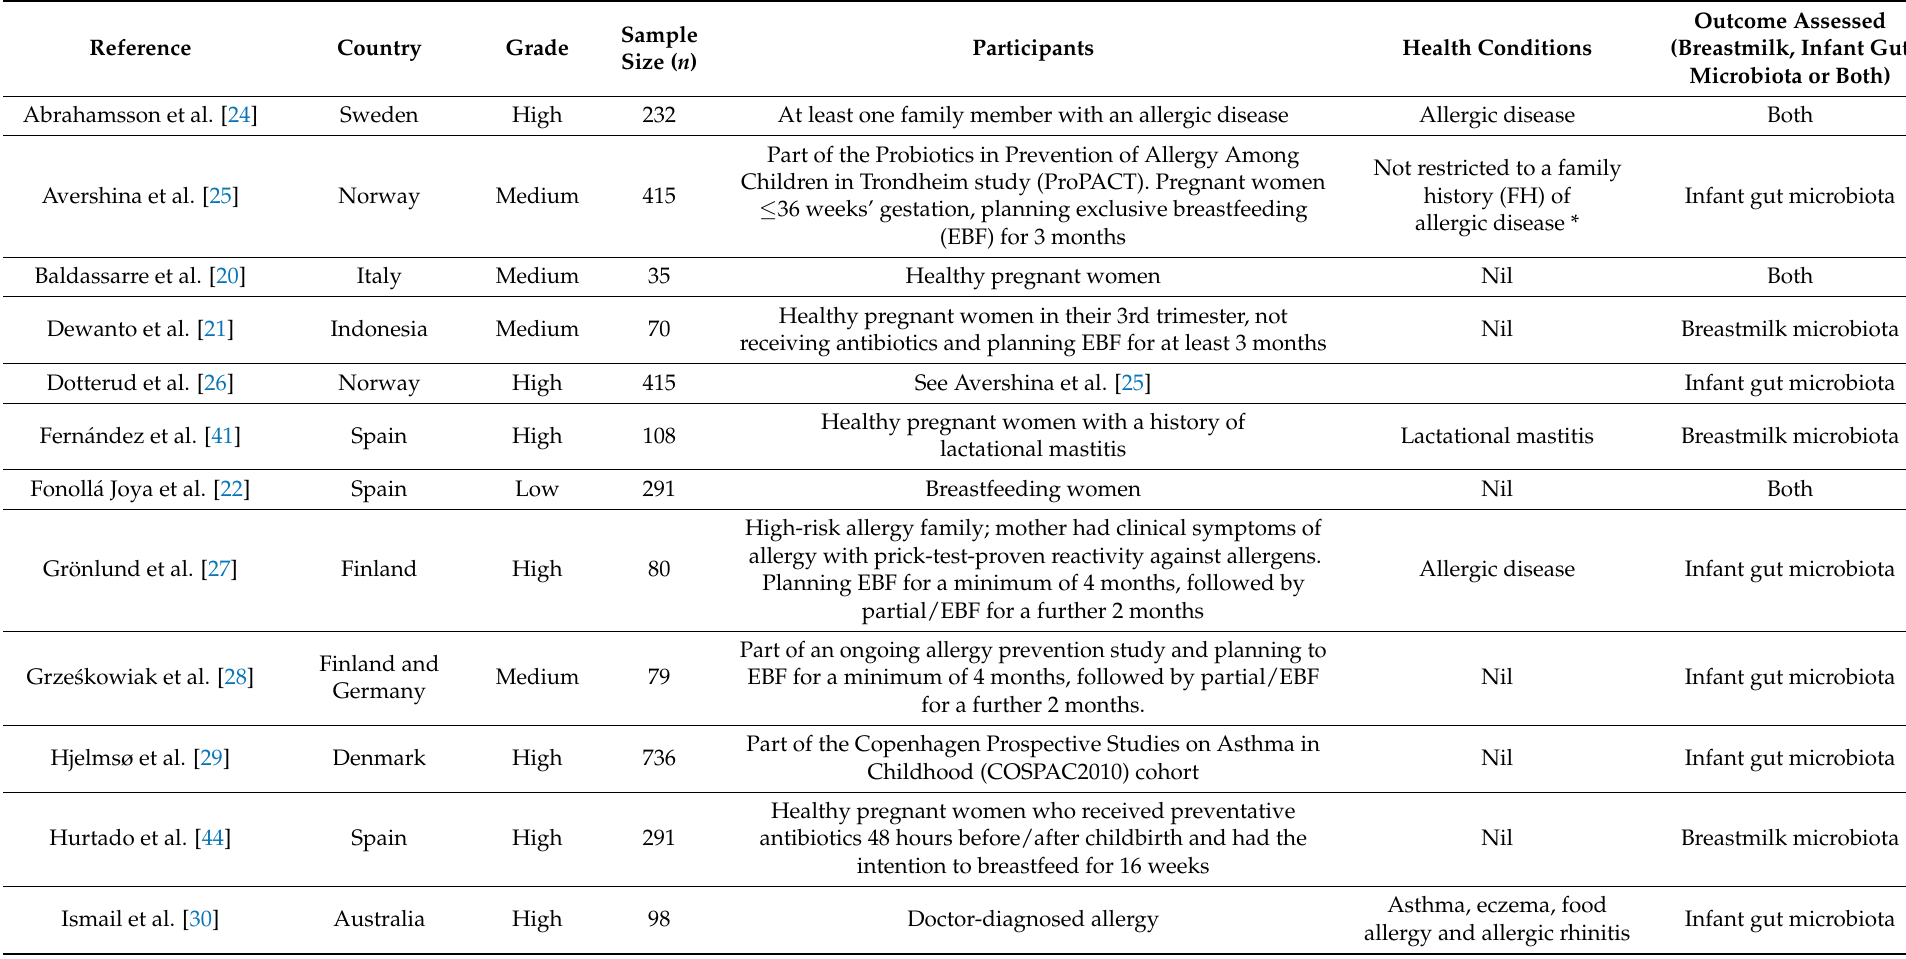
Table 1. Participant characteristics in included studies ( n =